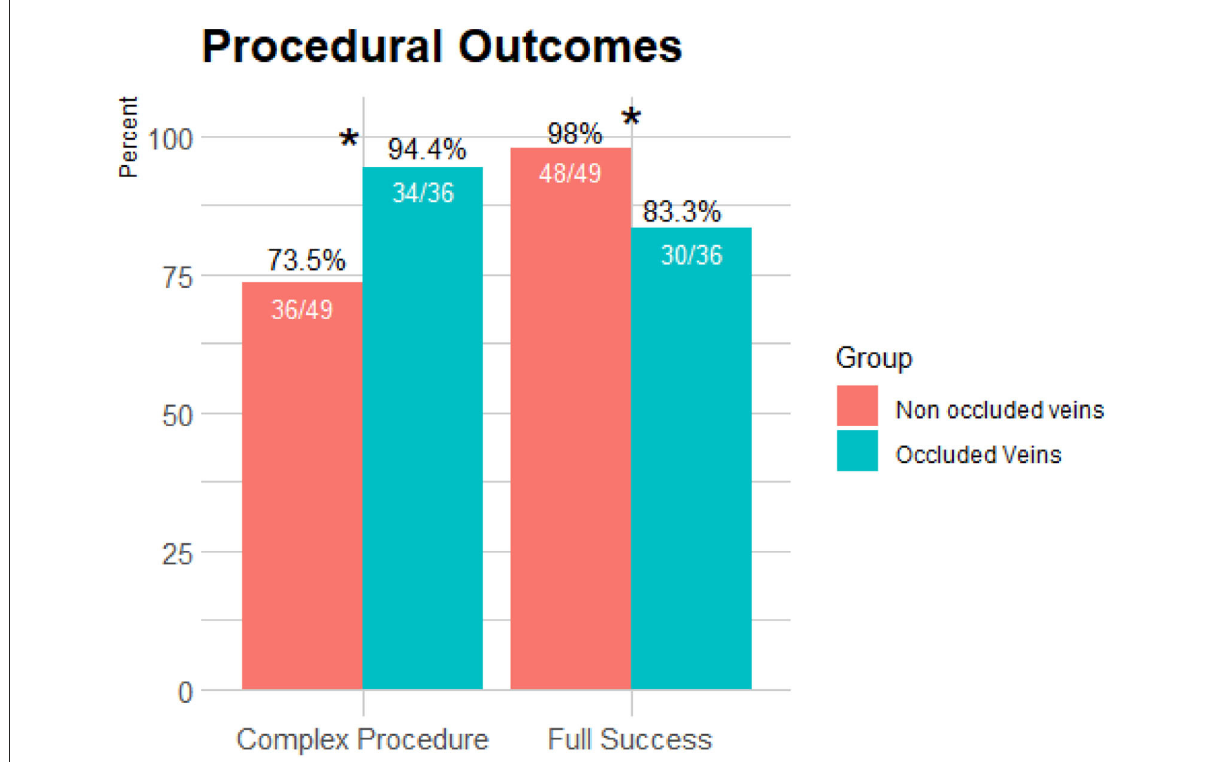
FIGURE2 Comparison of procedural outcomes between occluded and non-occluded vein groups. More complex methods were used for TLE in the presence of an occluded vein as compared to the non-occluded group ( p = 0.012). Radiological success was more common in the non-occluded group compared to the occluded vein group ( p = 0.047). * p <